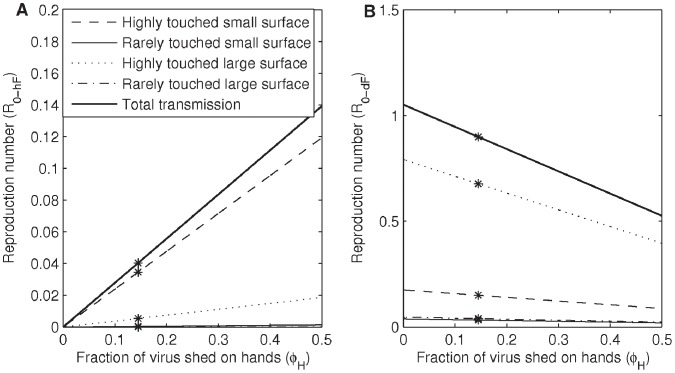
Transmission potentials (Reproduction number).A) Reproduction number for the hand-contaminated route (R0_hF) as functions of the fraction of virus shed on hands; B) reproduction number for the droplet-contaminated fomites route (R0_dF) as functions of the fraction of virus shed on hands. Note that scale for graph A) is one order of magnitude smaller than graph B). Values are shown for all fomites combined and individual fomite types. The upper limit of x-axis (0.5) is based on the assumption that the fraction shed to hands is less than that shed into air. The parameters for each of the four fomite classes graphed are presented in Tables 1 and 2. Stars in A and B are R0s of the two fomite routes when φH = 0.145.